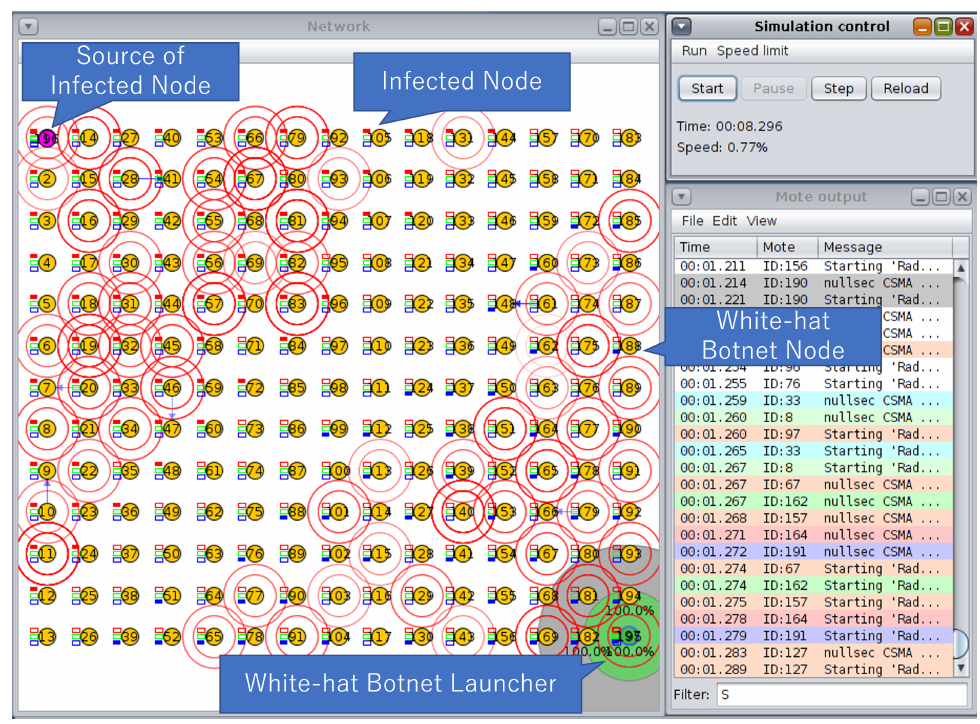
Figure 6. An illustration of a simulation